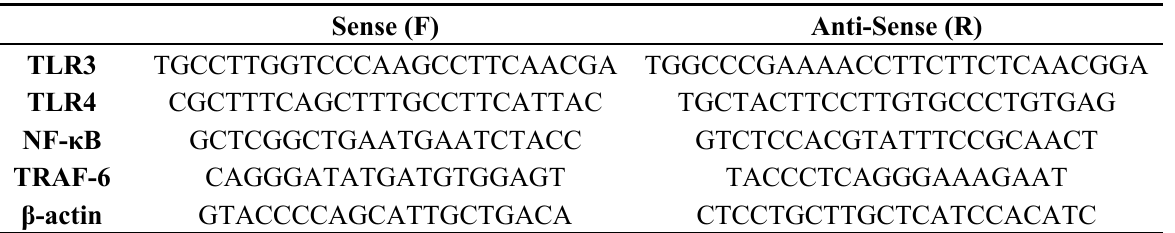
Table 2. The primer sequences of TLRs and their components of downstream signaling transduction